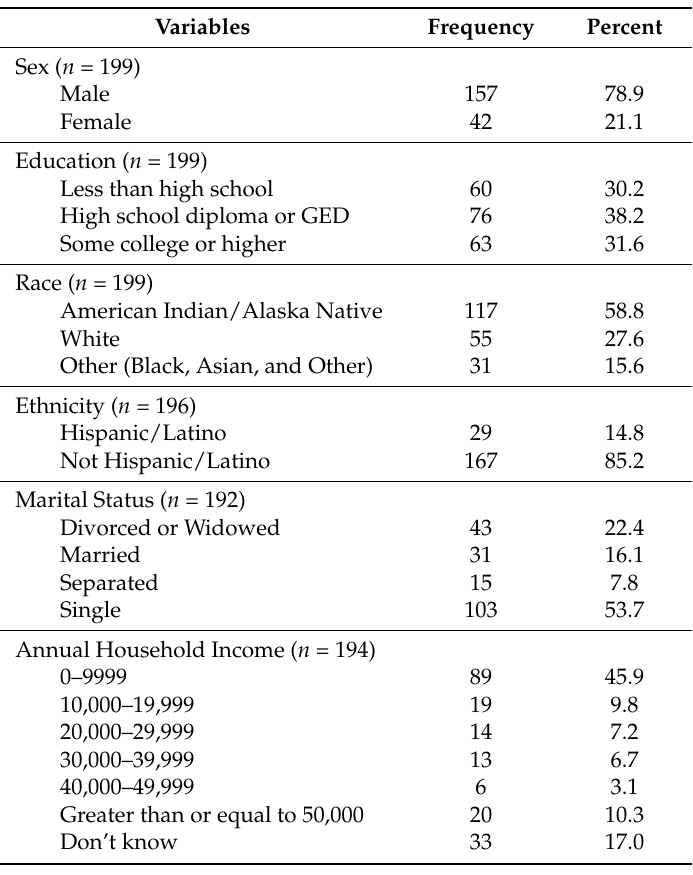
Table 1. Descriptive Statistics of Demographic